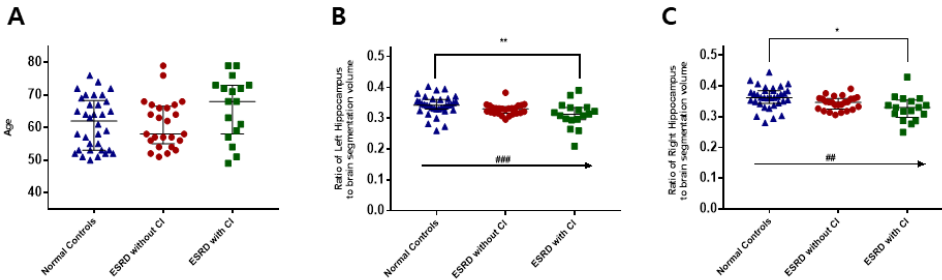
Figure 7. Hippocampal volume in control and end-stage renal disease patients with/without cogni- tive impairment. There was no difference among the groups ( A ). The ESRD patients with or without cognitive impairment had smaller left and right hippocampal volumes than the control subjects ( B , C ). ESRD patients with cognitive impairment had smaller left and right hippocampal volumes than ESRD patients without cognitive impairment ( B , C ). * p < 0.05, ** p < 0.01.